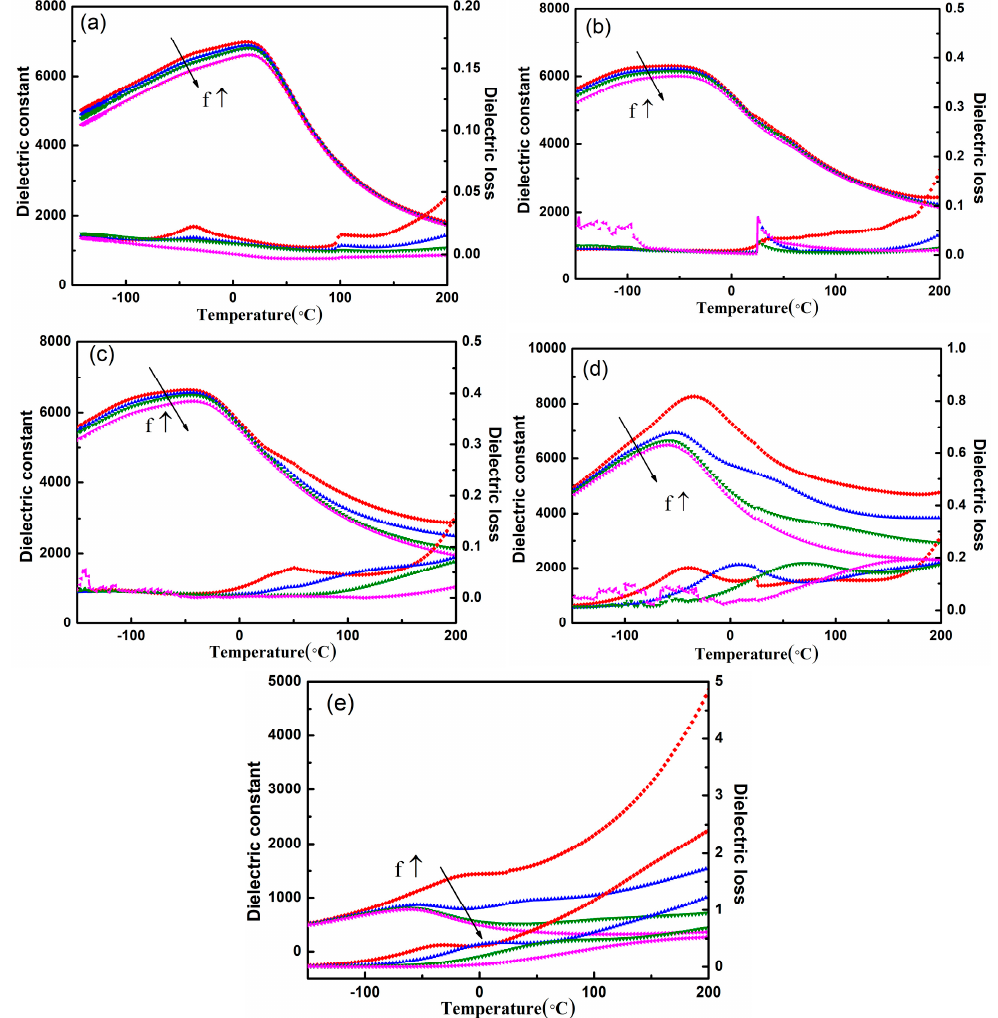
Figure 10. Temperature dependence of dielectric permittivity ε ’ and dielectric loss tan δ for the BST@Fe 2 O 3 ceramics with different coating amounts ( a ) 0 wt%, ( b ) 2.5 wt%, ( c ) 5 wt%, ( d ) 7.5 wt%, and ( e ) 10 wt% from 1 kHz to 1